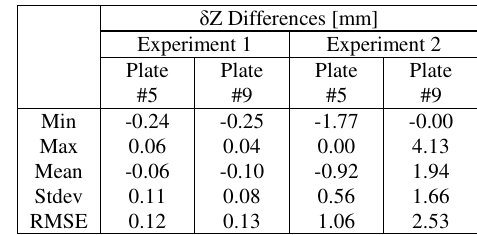
Table 1. Statistical properties for the deflection differences between the photogrammetric system and the laser transducers for all observed epochs